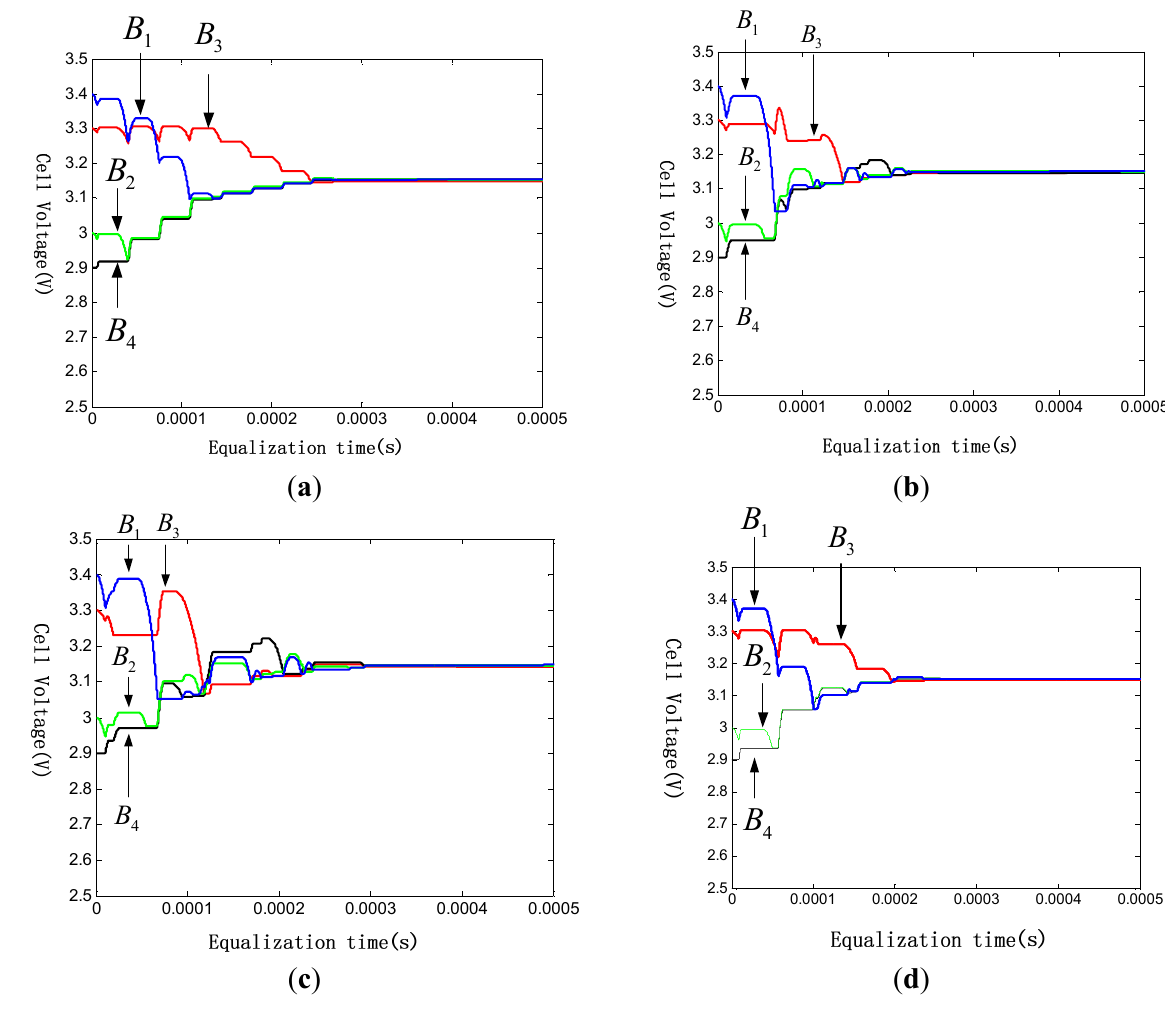
10. Cell voltages during static state with different balanced frequency: ( a ) Cell voltages during static state when dynamic balanced frequency (cid:1858) ( b ) Cell voltages during static state when dynamic balanced frequency (cid:1858) ( c ) Cell voltages during static state when dynamic balanced frequency (cid:1858) ( d ) Cell voltages during static state when dynamic balanced frequency (cid:1858)